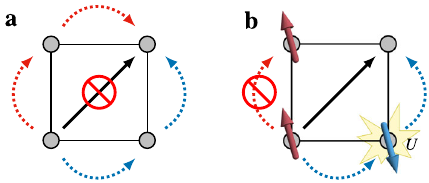
Fig. 2 Schematic picture for two-step hopping. a Photon-induced hopping processes in the noninteracting square lattice, where contributions from two different paths (red and blue dotted arrows) cancel with each other. b For a strongly-correlated model with an interaction U , the photon-induced hopping processes are sensitive to the charge and spin con fi gurations on the path, which lifts the cancellation in